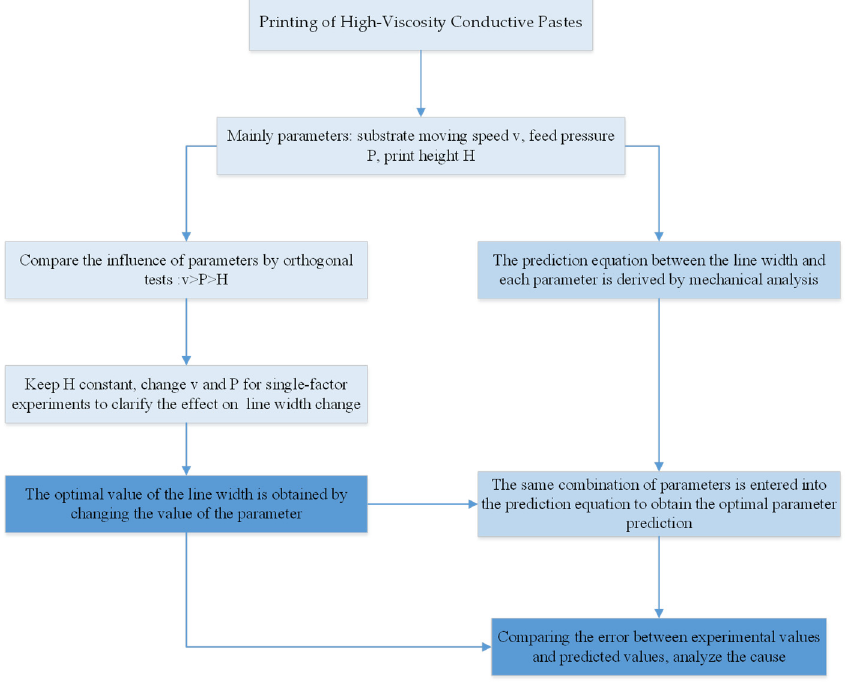
Figure 4. ( a ) Industrial camera real image of the printing process. ( b ) Schematic diagram of the paste printing model.